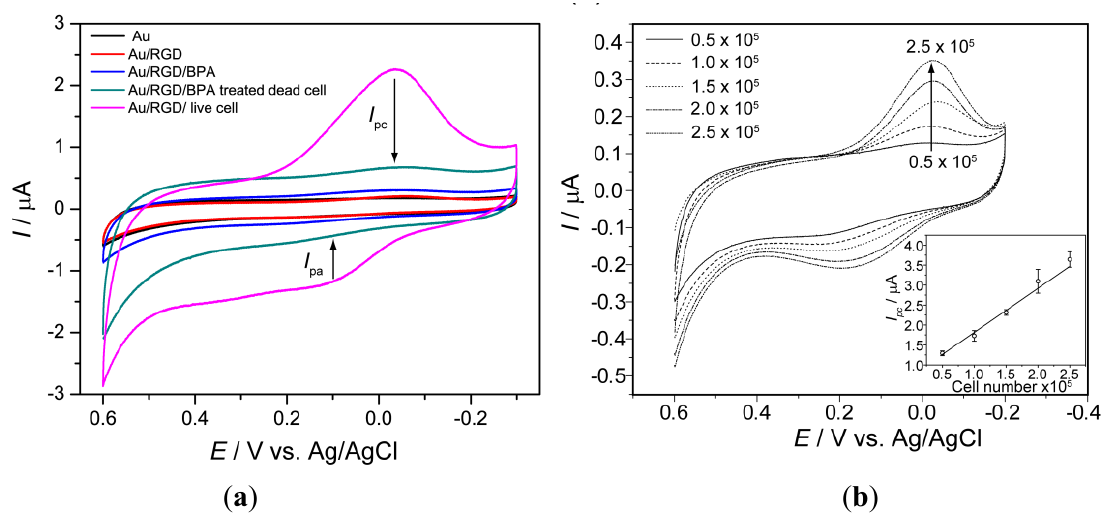
Figure 5. Characterization of chip: ( a ) Cyclic voltammograms from bare Au, Au/RGD, Au/RGD/BPA, Au/RGD/SH-SY5Y(with BPA) and Au/RGD/SH-SY5Y(without BPA) cells immobilized on an Au chip, ( ↓ ) indicates corresponding decreased peak due to 2 µM BPA treatment; ( b ) Cyclic voltammogram for SH-SY5Y cells with different numbers, ( ↑ ) arrow indicate current increased with cells number and inset shows linear plot of cathodic peak current ( I pc ) as a function of cell number, R 2 = 0.99. The voltametric measurements were performed using PBS (0.01 M pH 7.4) as an electrolyte at a scan rate of 100 mVs − 1 . Reproduced with permission from [12], Copyright 2011,